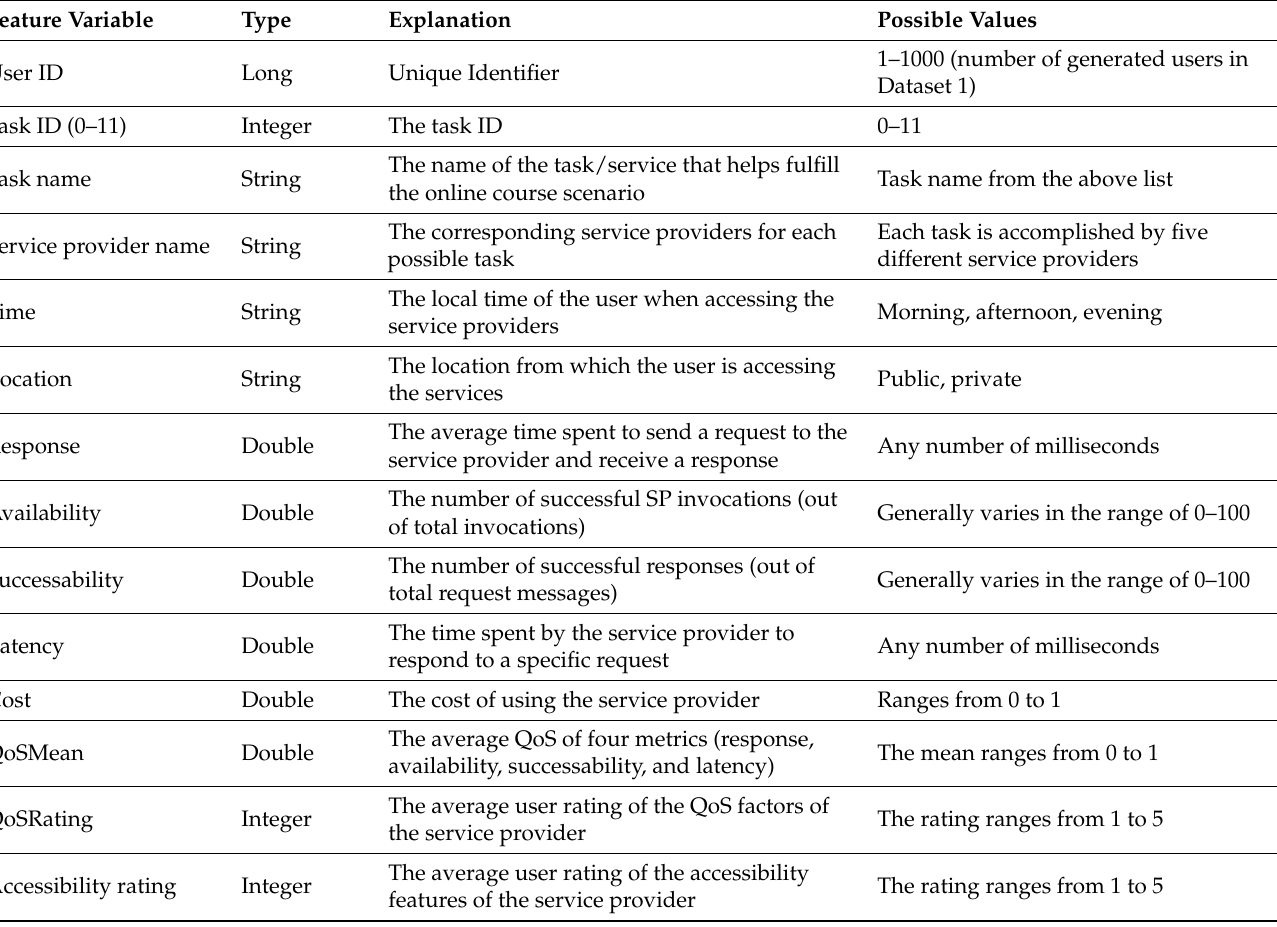
Table 4. Summary of feature variables of the second service providers